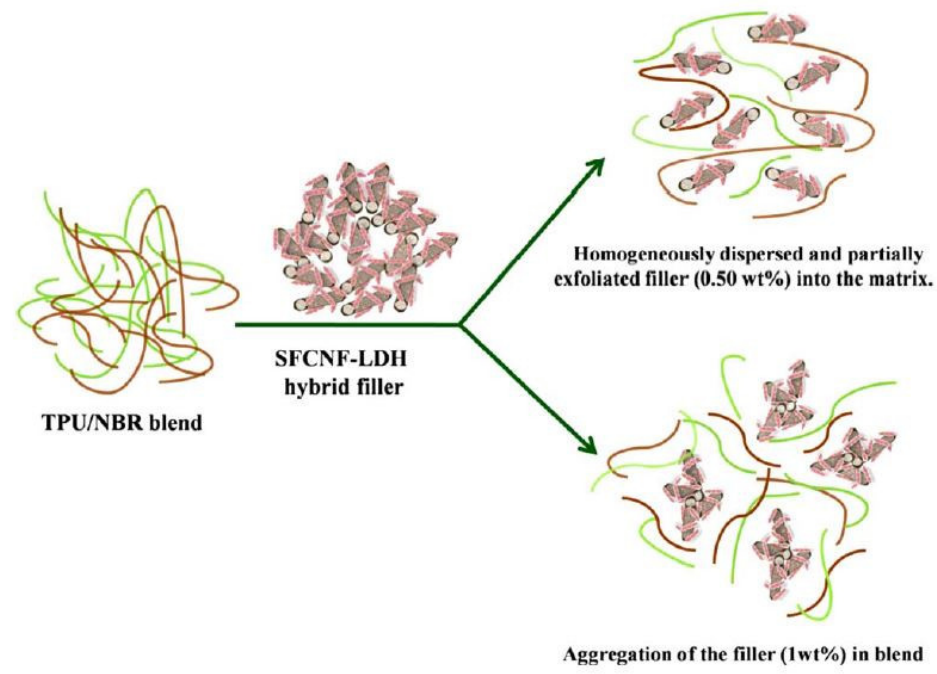
Scheme 2. TN blend without and with the filler to explain the mechanical properties.